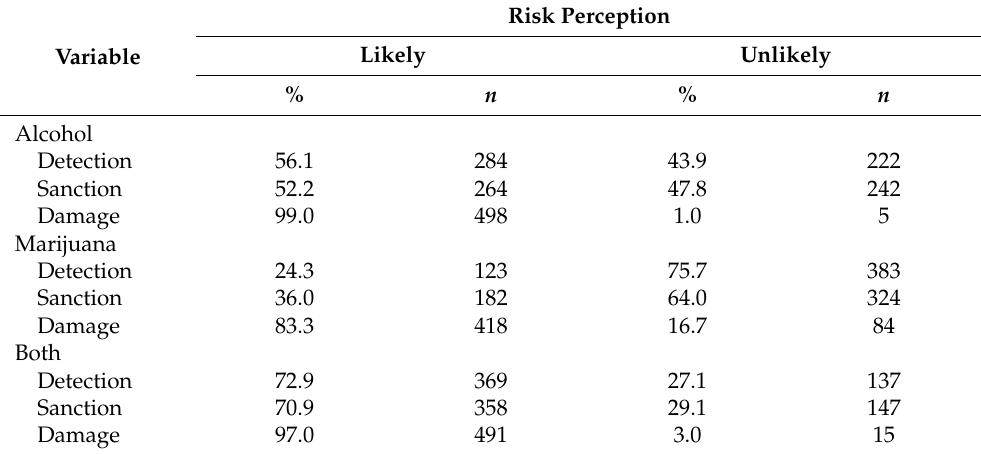
Table 2. Risk perception of DUI.